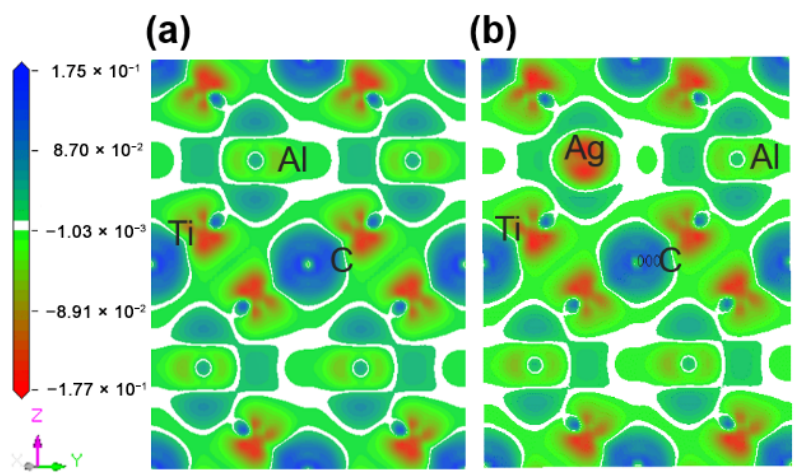
Figure 5. Maps of charge density difference of the Ti 2 (Al 1 − x ,Ag x )C supercells along the crystallo- graphic plane of 1010 : ( a ) Ti 2 AlC; ( b ) Ti 2 (Al 0.875 ,Ag 0.125 )C. Table 2. Atomic orbital charge populations of Ti 2 AlC and Ti 2 (Al 0.875 ,Ag 0.125 )C supercells. Supercell